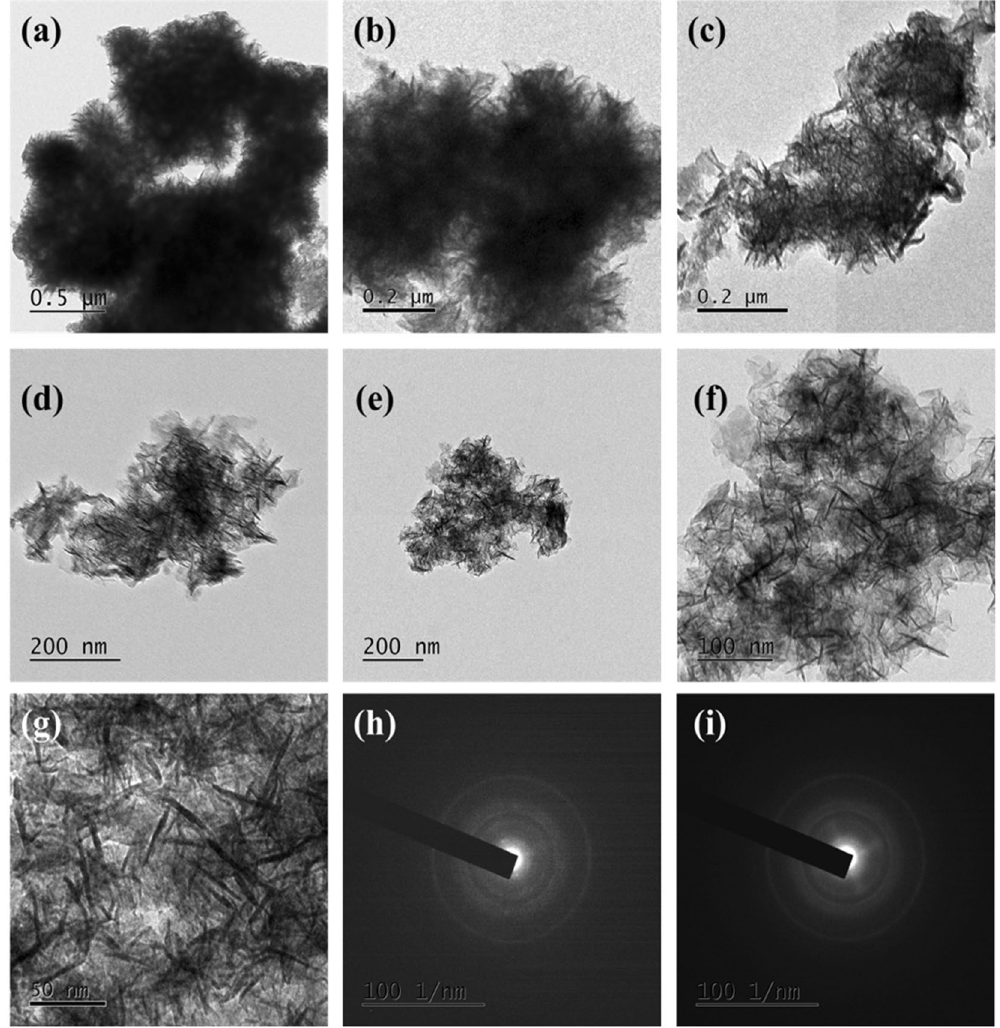
Figure 5. ( a – g ) FE-TEM images of Co 3 O 4 @MnO 2 /NGO at different particle sizes and ( h , i ) SAED array of Co